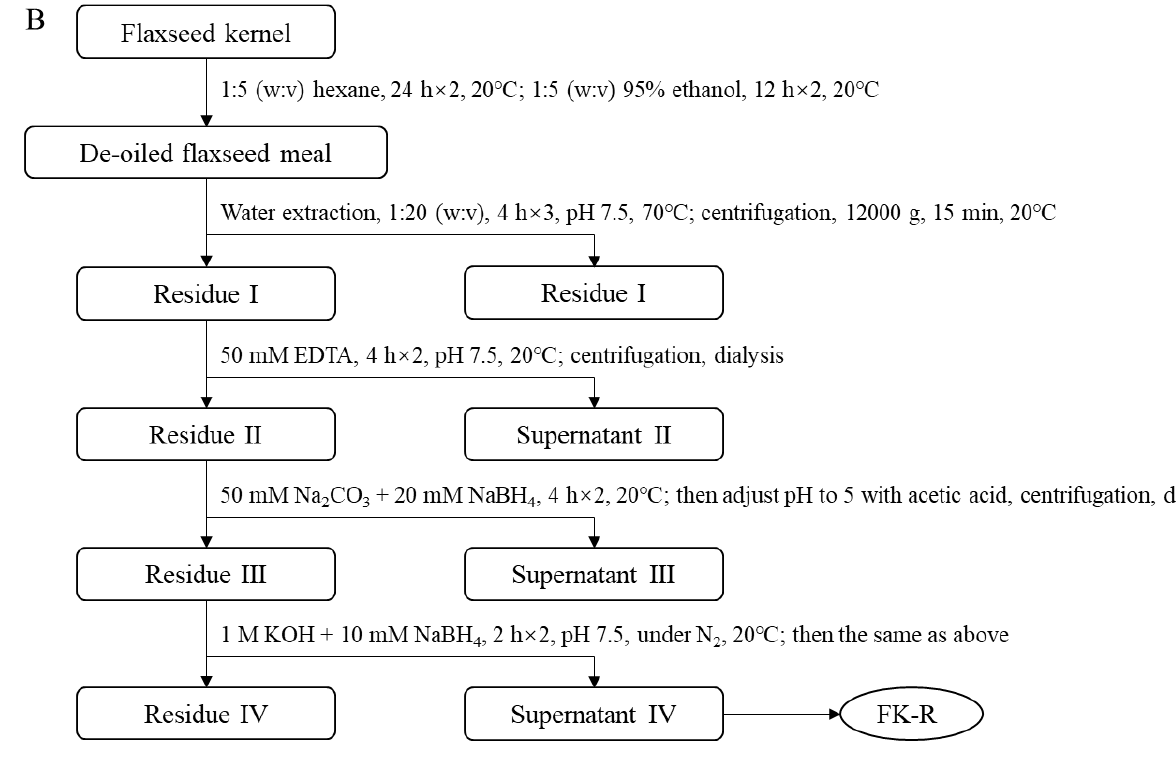
Figure 2. Extraction and purification process (( A ), flaxseed hull mucilage gum, adapted with per- mission from Ref.[8]; ( B ), flaxseed kernel, adapted with permission from Ref. [2]).